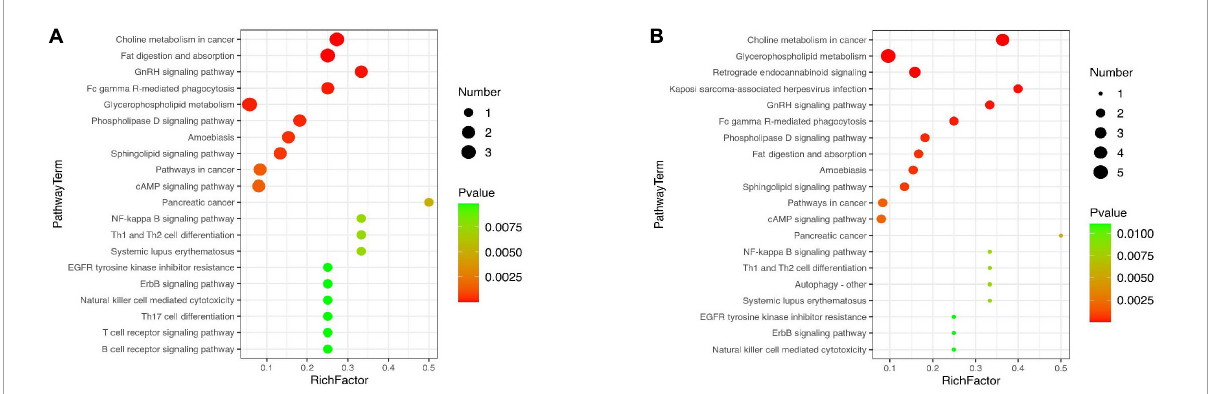
FIGURE5 Lipid metabolism pathway analysis based on KEGG enrichment map for significantly different lipid species in HFD vs. ND (A) and AEE vs. HFD (B) . In the metabolic pathway P -value was the significance of the metabolic pathway, and the significance-enriched pathway was selected for bubble mapping. The ordinate was the name of the metabolic pathway and the abscissa was the Rich factor. The larger the Rich Factor was, the greater the enrichment would be. The color from green to red indicated that P -value decreased in turn, and the lower P -value represents the more significant degree of enrichment. A larger dot indicates a greater number of metabolites were enriched on this pathway.